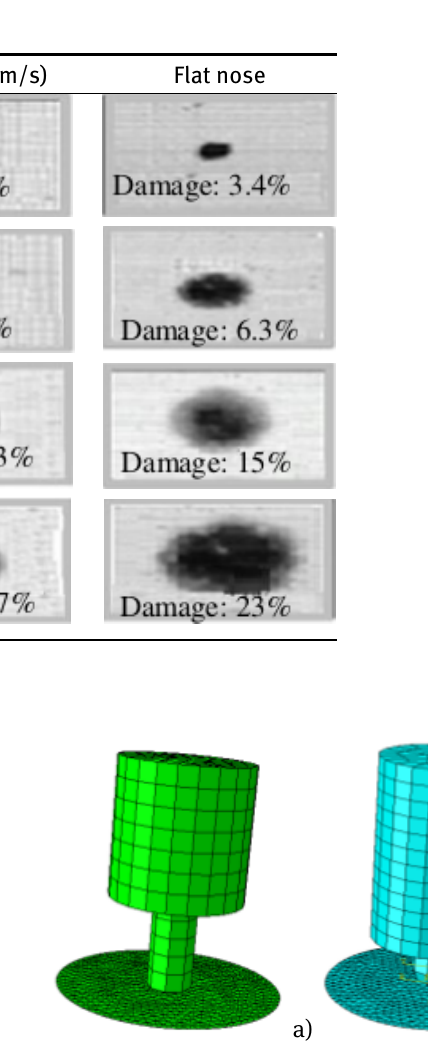
Table 2: Impact damage produced at different velocities.